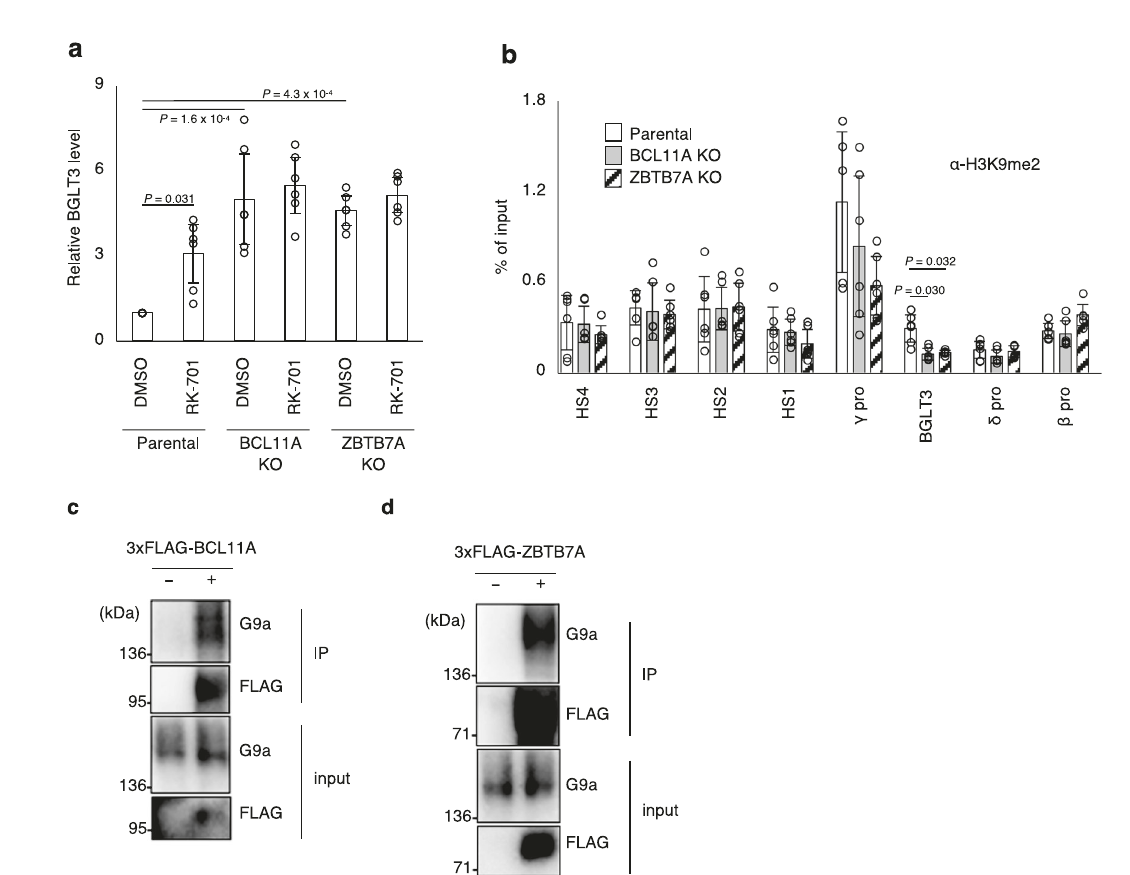
Fig. 4 | Regulation of G9a-induced H3K9me2 at the BGLT3 gene locus by BCL11A and ZBTB7A. a Effect of BCL11A or ZBTB7A knockout on RK-701 – induced expression of BGLT3. Relative expression of BGLT3 in parental, BCL11A-, or ZBTB7A-knockout HUDEP-2 cellstreatedwith 1 μ M RK-701for 4 days wasanalyzed by RT-qPCR. Data are mean±SD from three independent experiments. b ChIP- qPCRanalysesusinganantibodyagainstH3K9me2inparental,BCL11A-,orZBTB7A- knockoutHUDEP-2cells.Dataaremean±SDfromthreeindependentexperiments.